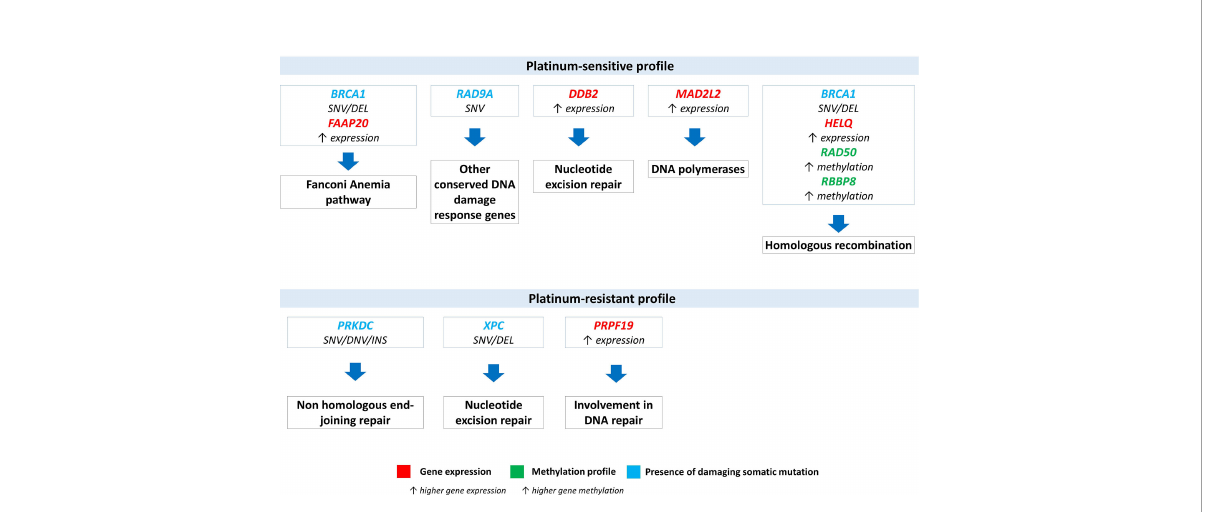
FIGURE 6 Overview and pathway classi fi cation of DNA repair genes with signi fi cant deregulation based on platinum-resistant status. Signi fi cant expression changes ( DDB2, PRPF19, HELQ, MAD2L2 in red), signi fi cant changes in methylation pro fi le ( RAD50 ), signi fi cant intersections from eQTL analysis ( XPC, PRKDC and FAAP20 ) and signi fi cant intersections from mQTL analysis ( BRCA1, RAD9A and RBBP8 in blue). SNV (single nucleotide variant), DEL (deletion), DNV (double nucleotide variant), INS